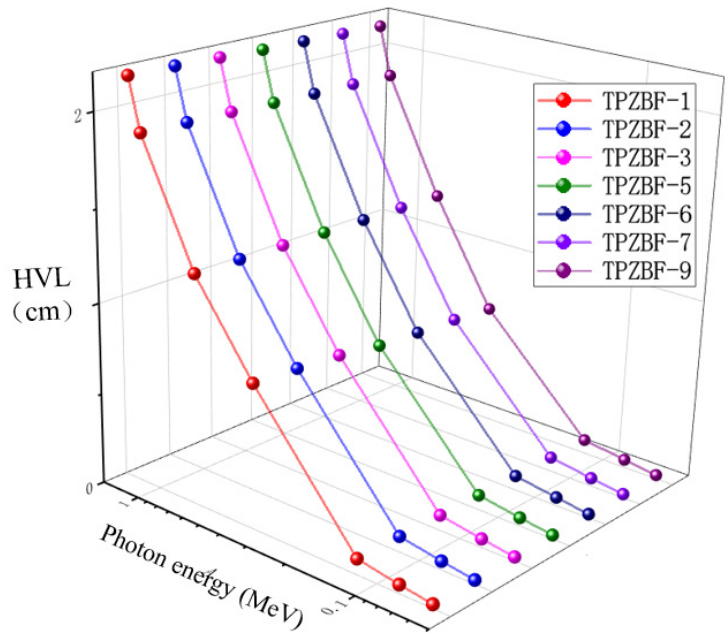
Figure 5. The relationship between HVL value and photon energy and BaF 2 content.